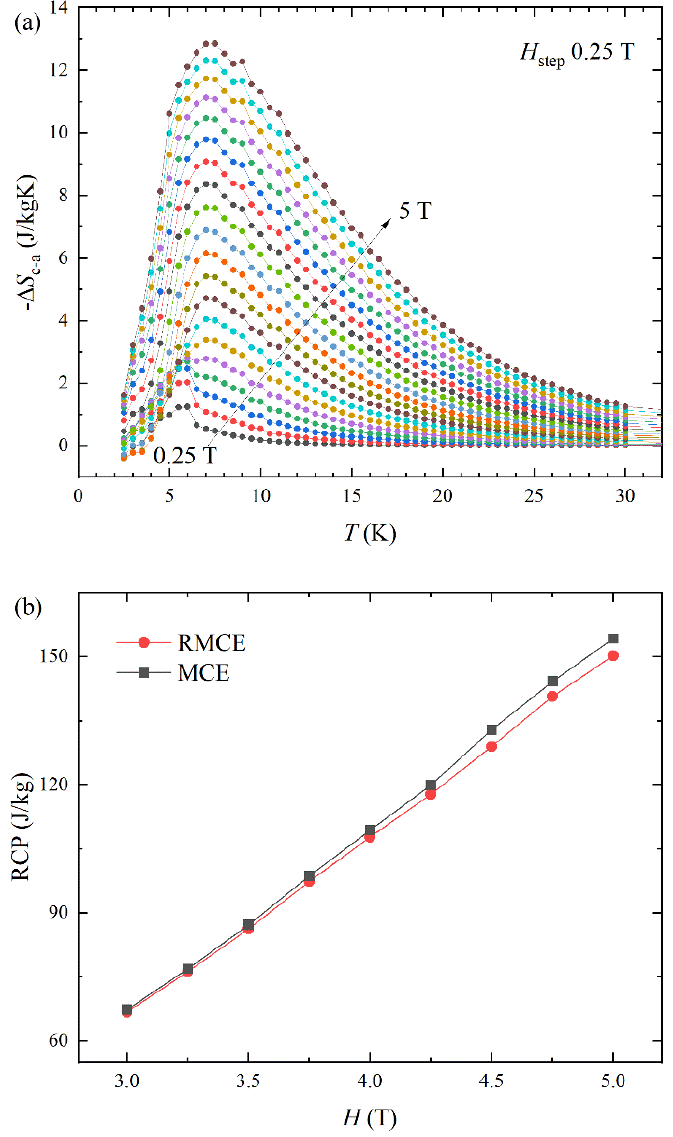
Figure 5. Rotational magnetocaloric effect (R-MCE) − ∆ S c − a ( a ) and relative cooping power (RCP) of MCE and R-MCE ( b ) of